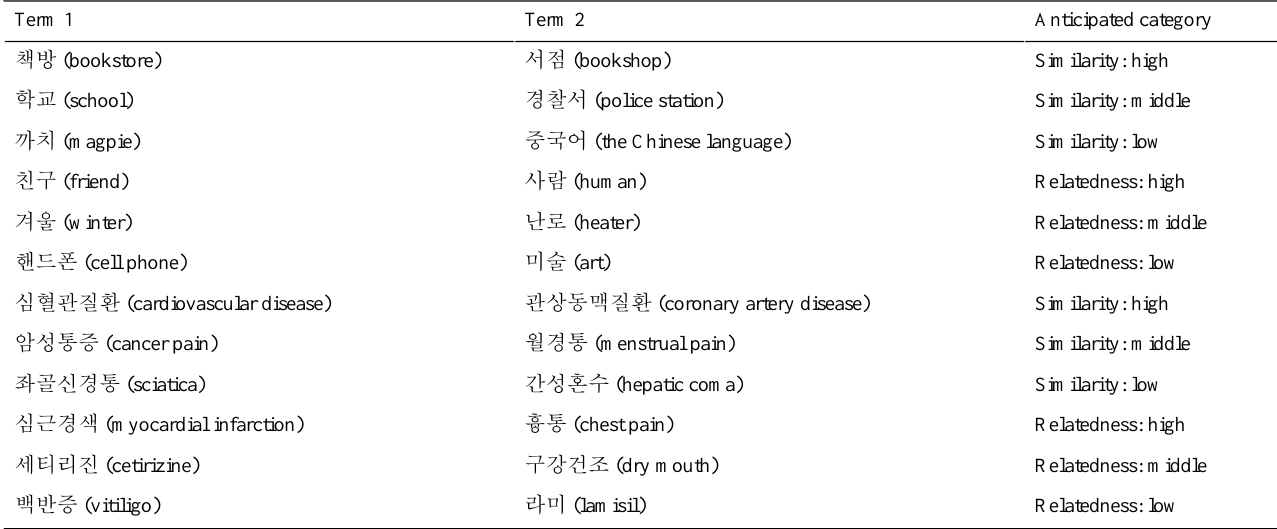
Table 1. Examples of the practice session for human validation in which word pairs of the practice session included medical as well as general terms. Term 1 and Term 2 were presented to the participants. However, their anticipated similarity and relatedness categories were kept